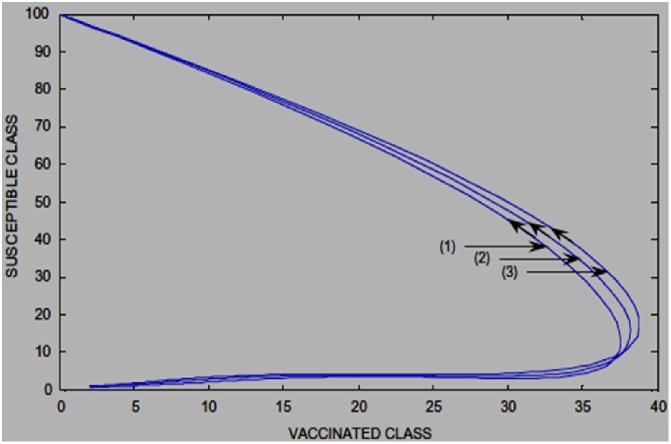
Susceptible vs Vaccinated Class [12].